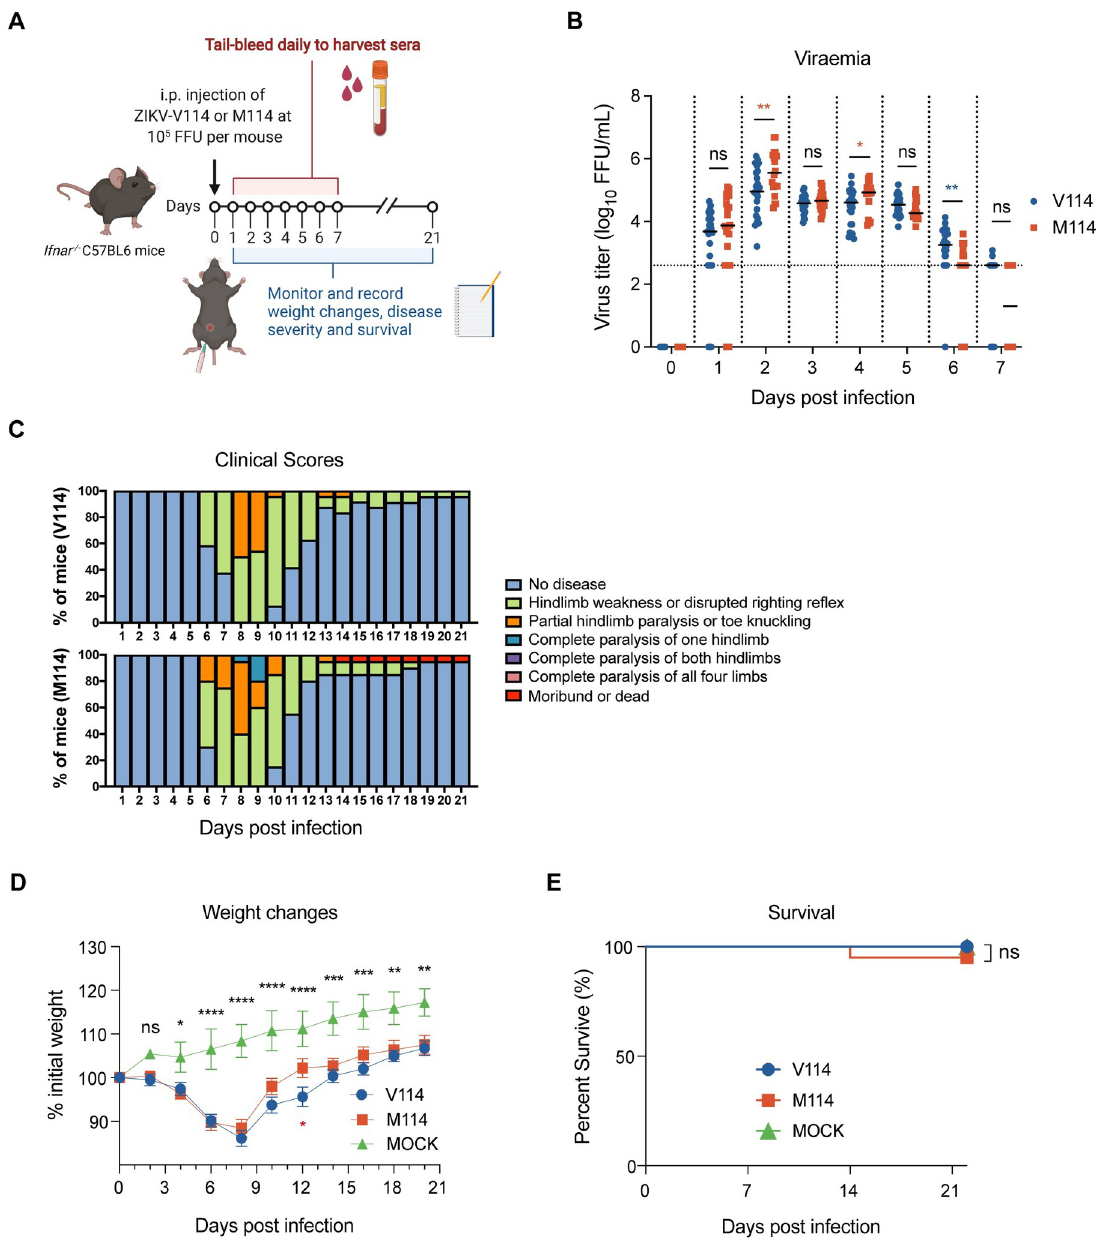
Fig 4. Characterization of ZIKV NS5-M114V mutation on virulence in mice. ( A ) Schematic outline of mice study created with BioRender.com. Five-to-six weeks-old gender-balanced Ifnar -/- mice were either uninfected (na ï ve) or intraperitoneally (i.p.) challenged with 10 5 focus-forming-units (FFU) of NS5-V114 or NS5-M114 ZIKV (10 mice/group) and monitored for 21 days. Two independent experiments were performed, and combined data from two experiments were presented. ( B ) Virus titers from sera harvested daily for 7 days post infection and determined by immuno-plaque assay (iPA). Horizontal dotted lines represent the limit of detection of 2.6 log 10 FFU/mL. ( C ) Clinical scores for disease symptoms and progression monitored daily for 21 days. ( D ) Weight changes of mice measured every 2 days upon infection for 21 days. ( E ) Overall survival rate of V114 and M114 ZIKV infected mice compared to na ï ve uninfected mice over 21 days. The statistical significance of differences in viremia, weight changes and Kaplan-Meier survival curves between strains was determined using Mann-Whitney test and Log-rank (Mantel-Cox) test respectively. “ns”, not significant, � p � 0.05, �� p � 0.005, ��� p � 0.0005, ���� p �